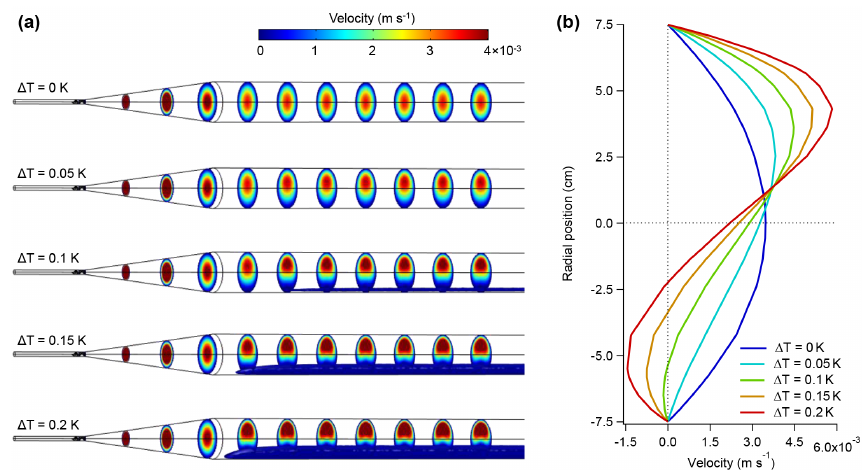
Figure 7. COMSOL simulated flow profiles as a function of reactor wall temperature gradient (cid:49)T . (a) Three-dimensional simulation results demonstrating cross-sectional velocity profiles and consequential recirculation zones (blue isosurface). (b) One-dimensional velocity profiles at axial position z =